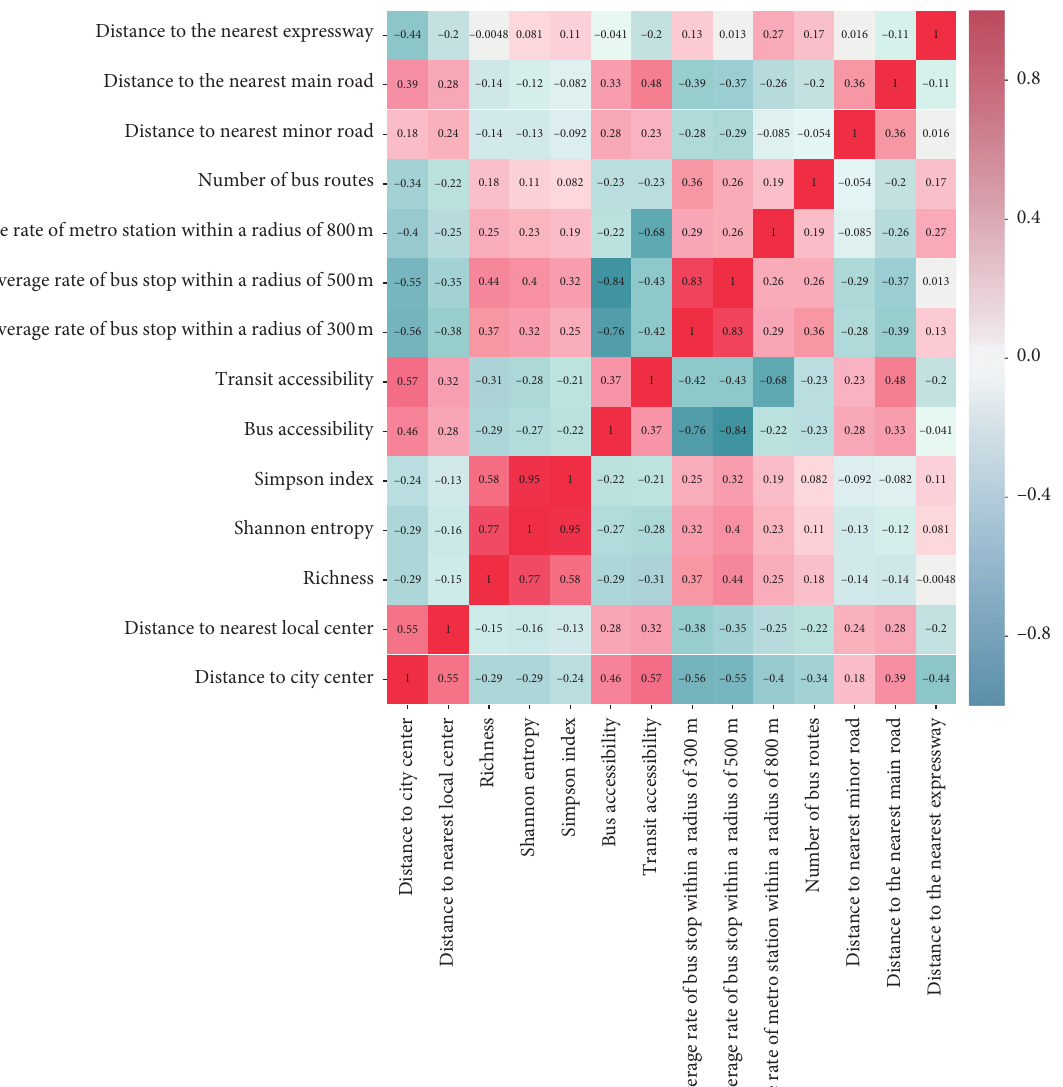
Figure 5: Correlation analysis of variables based on Pearson’s correlation coefficient.